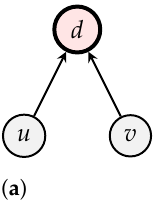
Figure 12. One transceiver cannot be involved in multiple communications within the same timeslot. ( a ) Simultaneous transmission to the same parent. ( b ) Simultaneous reception and transmission. (Rule 2) Interference constraint. Communications within timeslots are